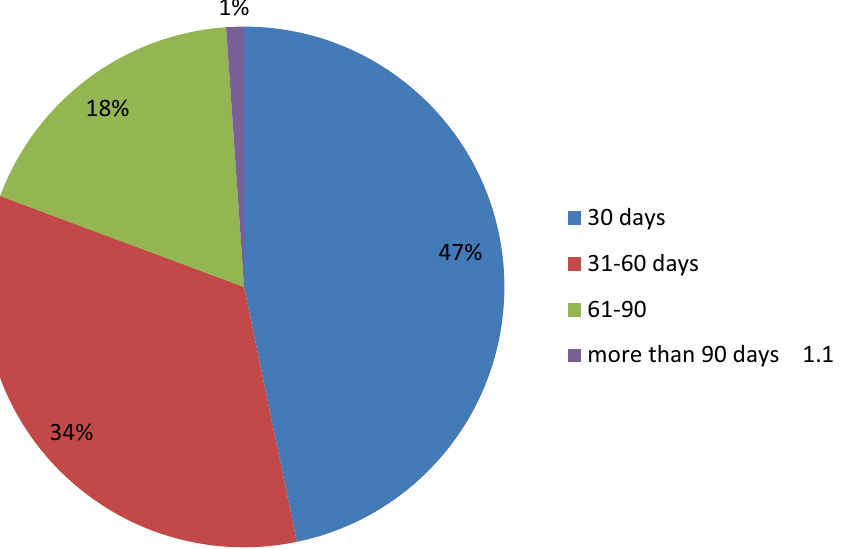
Figure 1. Utilization of iron supplementation among pregnant women at Robe town, Bale zone, Southeast Ethiopia, 2015 (n =